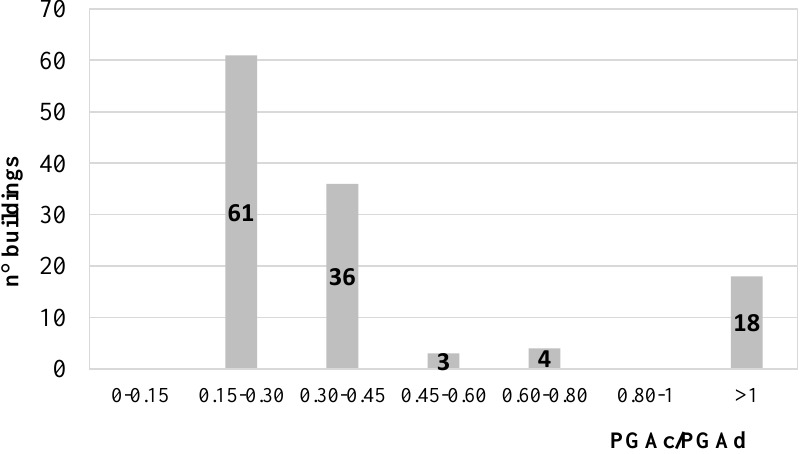
Figure 10. Range of PGA c /PGA d according to the method of Grant for 122 RC buildings.